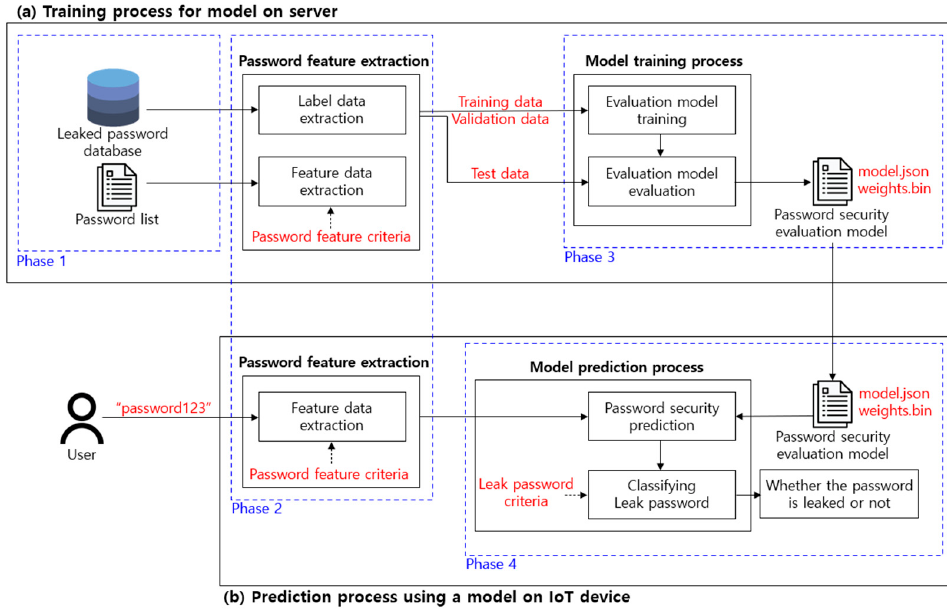
Figure 5. Phases of the proposed method: ( a ) training process for model on server; ( b ) prediction process using a model on IoT